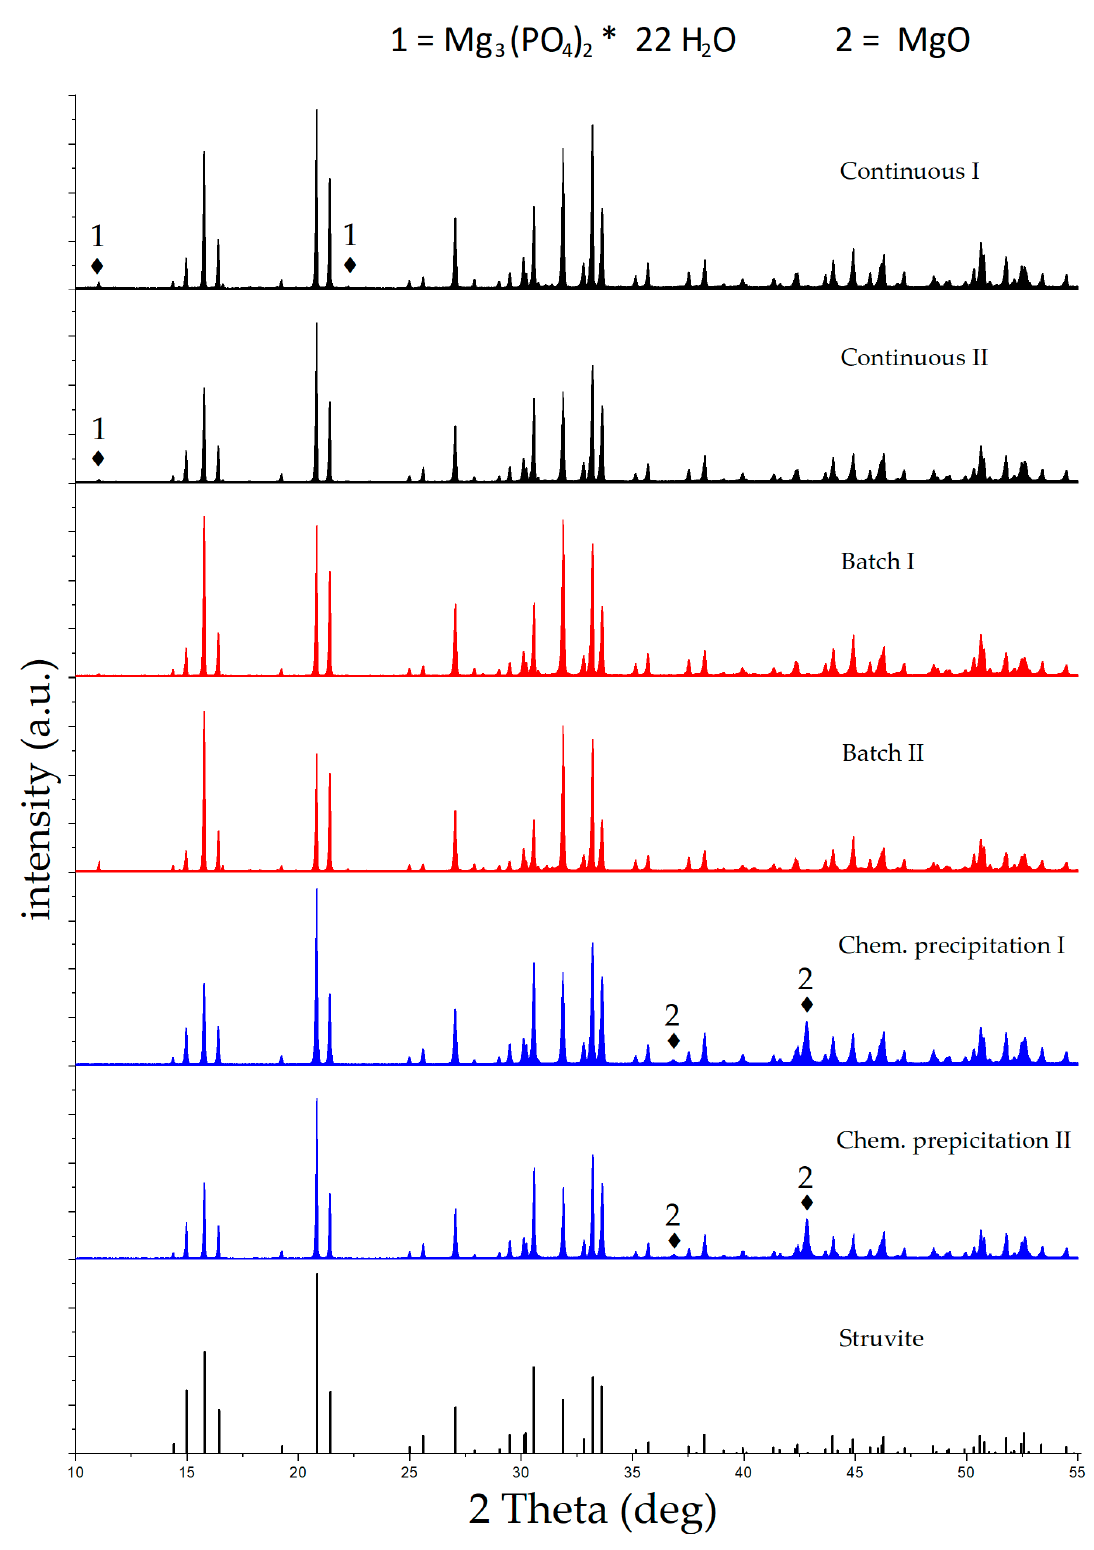
Figure 3. XRD (X-ray diffraction) patterns for the sludges obtained from the synthetic water samples subjected to BEC, CEC, and CP (chemical precipitation) for struvite precipitation.